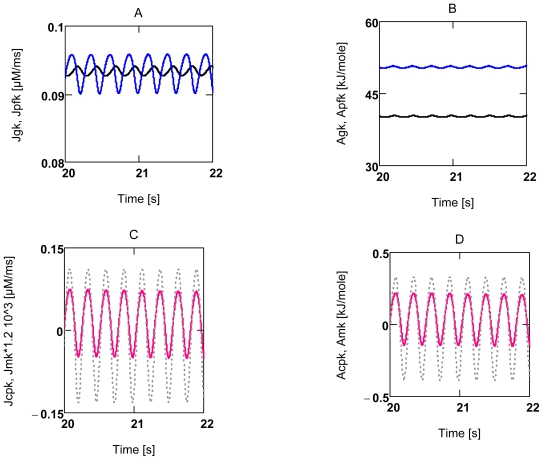
Oscillating fluxes at high and low affinities. A: (black) JGK, (blue) JPFK; B: (black) AGK, (blue) APFK; C: (red) JCPK, (grey dots) JMK; D: (red) ACPK, (grey dots) AMK. Near equilibrium fluxes (panel C) are appreciably more influenced by respective affinities than fluxes far from equilibrium (panel A).